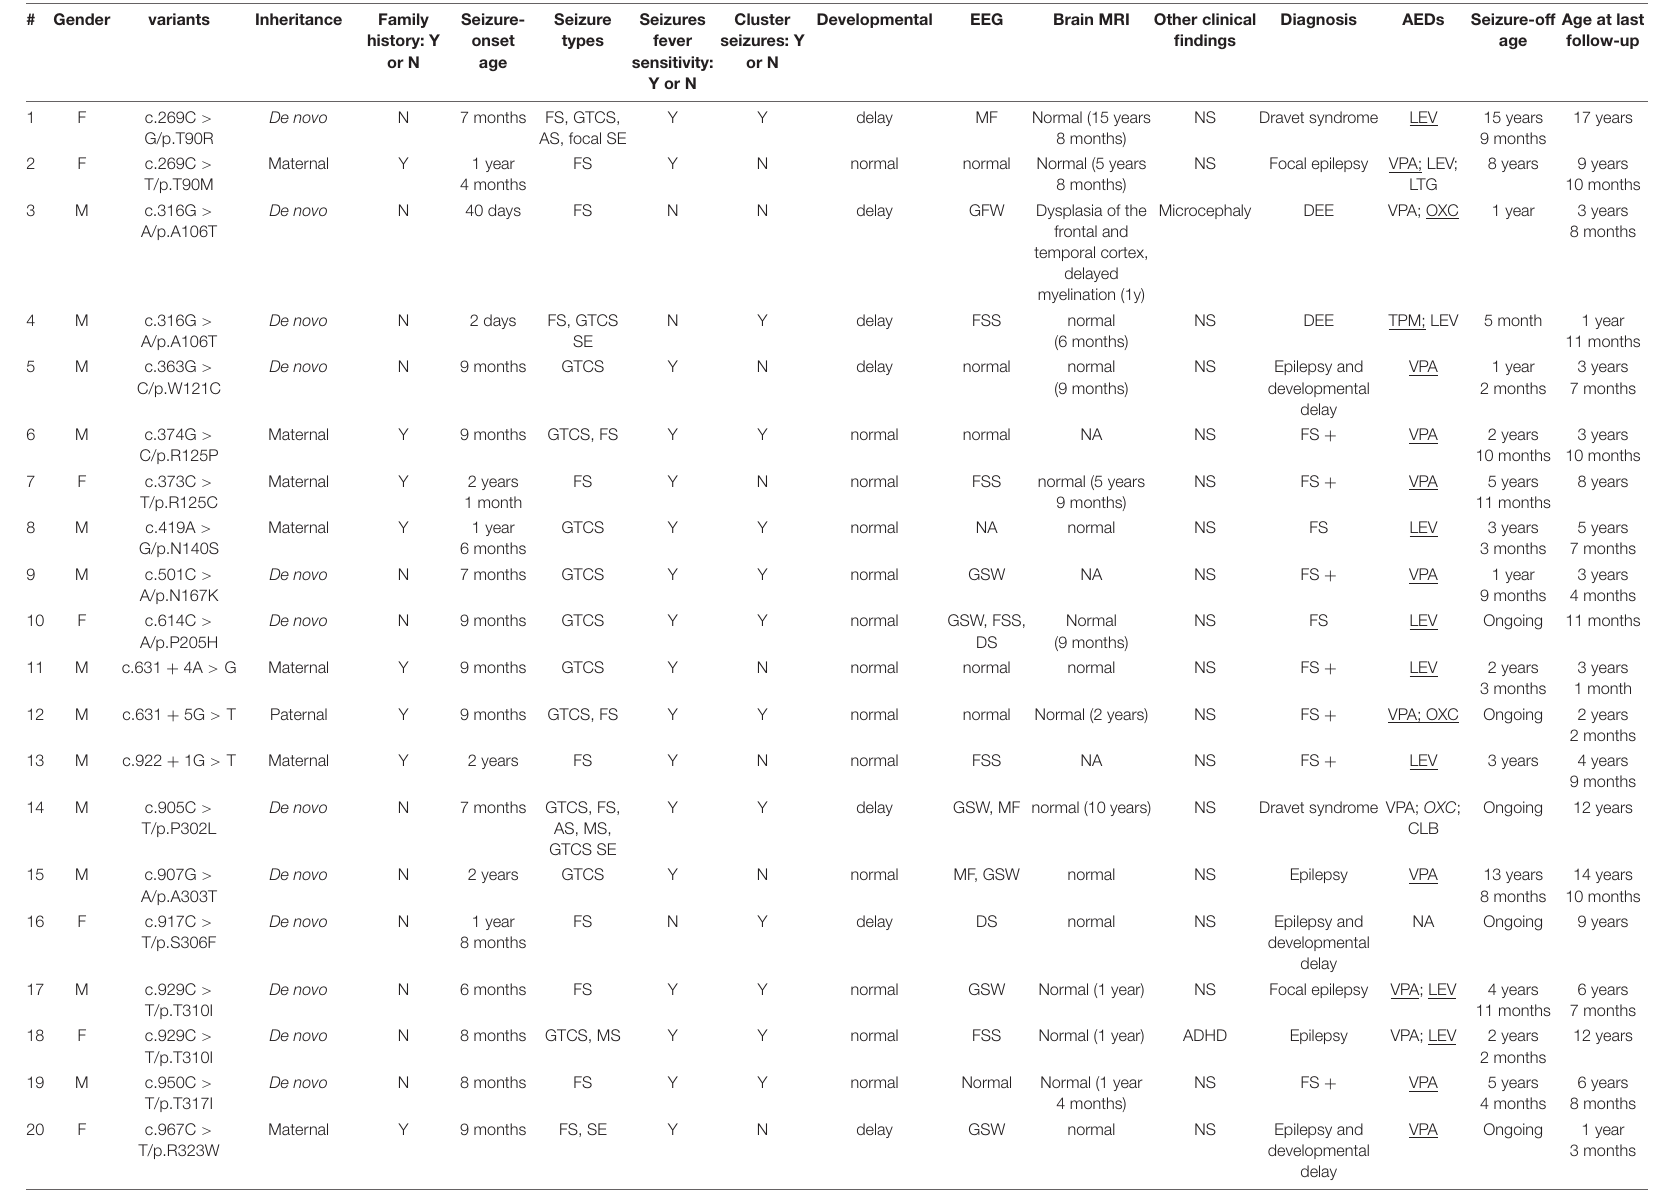
TABLE 1 | The phenotype and genotype of 35 patients with GABRG2 variants in our